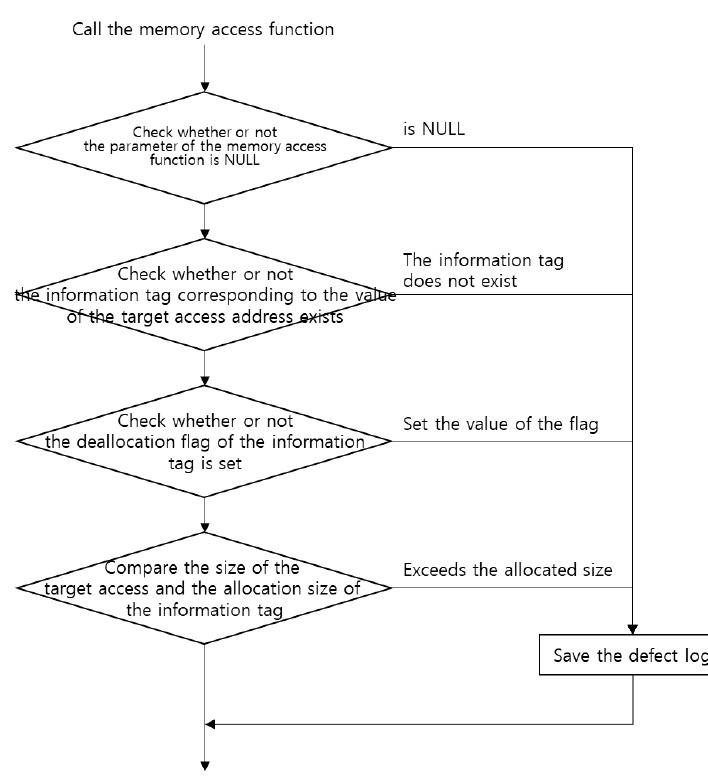
Figure 8. Real-time defect-detection: memory access.